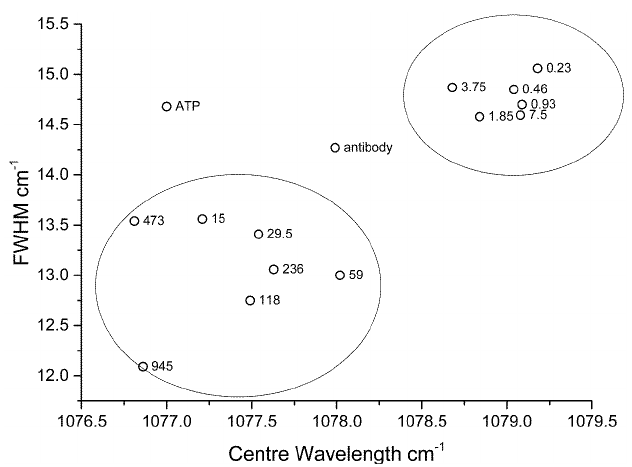
Figure 10. Correlation between peak centre and FWHM. Labels on the data points show the p53 concentrations (nM). The data for ATP and anti-p53 only are clear